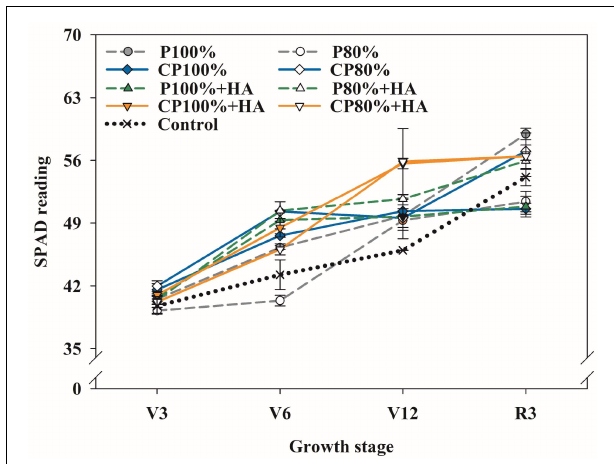
FIGURE 5 | Changes in the reading of Soil Plant Analysis Development (SPAD) chlorophyll meter with maize growth in different fertilization treatments. Control, no P fertilizer added; P 100%, diammonium phosphate (DAP) at 75 kg P 2 O 5 ha − 1 ; P 80%, DAP at 60 kg P 2 O 5 ha − 1 ; CP 100%, coated DAP (CDAP) at 75 kg P 2 O 5 ha − 1 ; CP 80%, CDAP at 60 kg P 2 O 5 ha − 1 ; P 100% + HA, DAP at 75 kg P 2 O 5 ha − 1 and combined with humic acid (HA); P 80% +H A, DAP at 60 kg P 2 O 5 ha − 1 and combined with HA; CP 100% + HA, CDAP at 75 kg P 2 O 5 ha − 1 and combined with HA; CP 80% + HA, CDAP at 60 kg P 2 O 5 ha − 1 and combined with HA. V3, seedling stage; V6, six-leaf stage; V12, twelve-leaf stage; R3, milk stage.